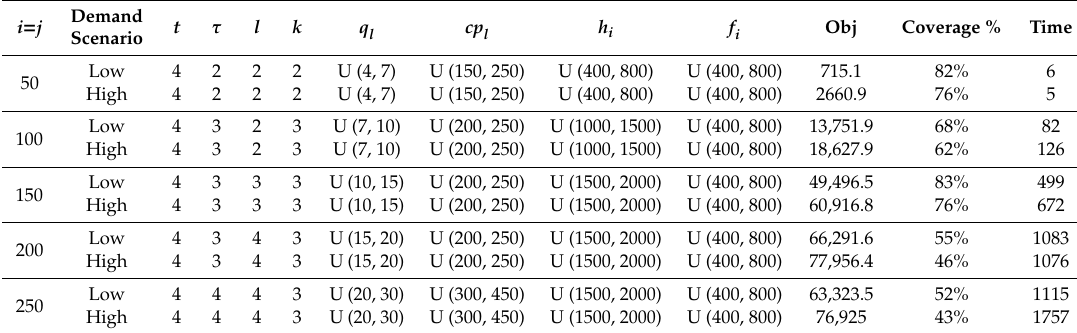
Table 4. Computational results of test problems for four regions’